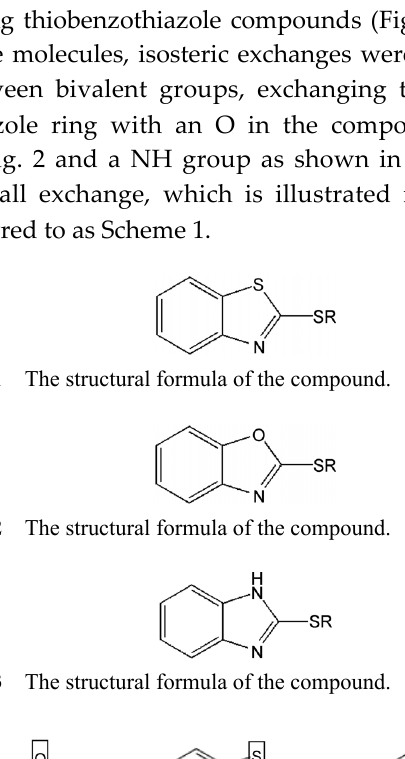
Fig. 10 The structural formula of the